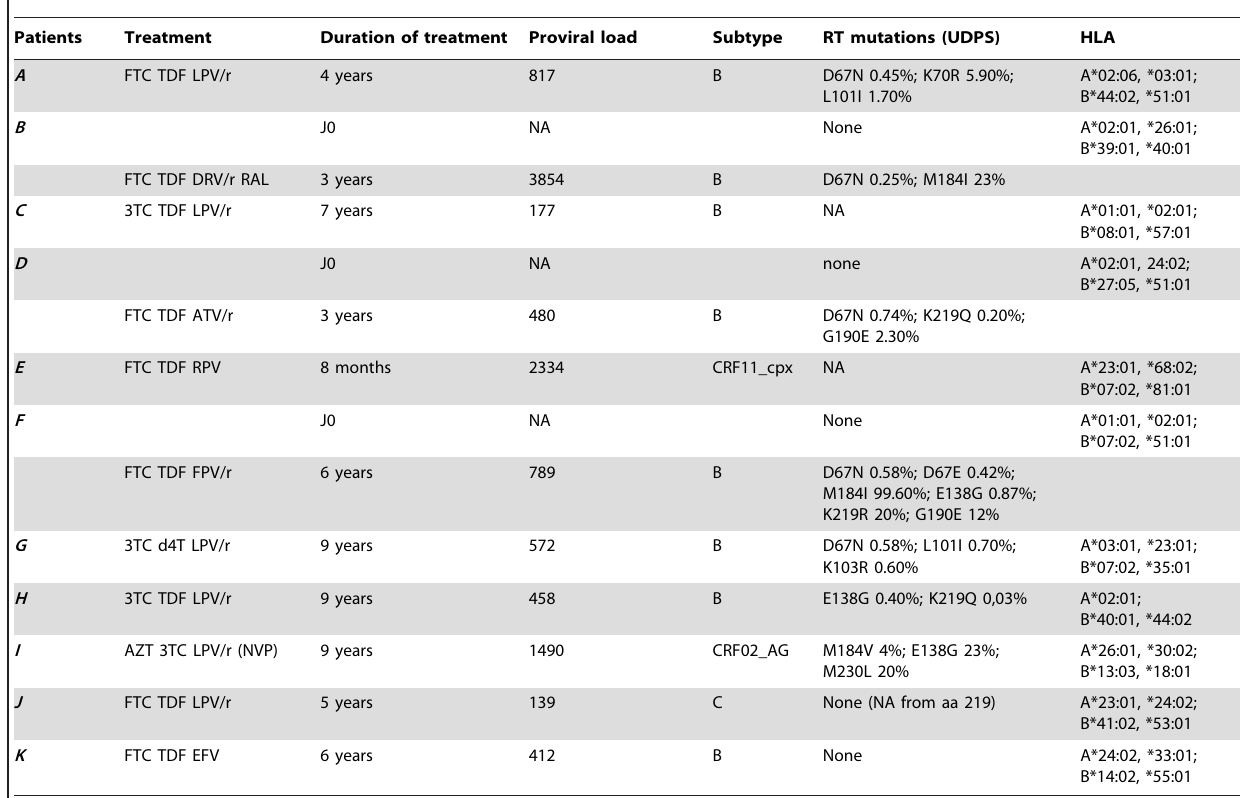
Table 1. Antiretroviral treatment and duration, HIV-1 proviral load, viral subtype, resistance mutations in RT, immunogenetics of